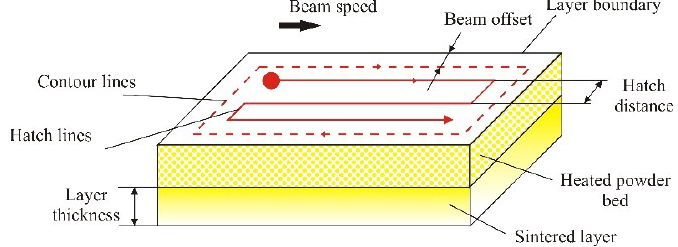
Figure 2. Hatch distance [22,23].